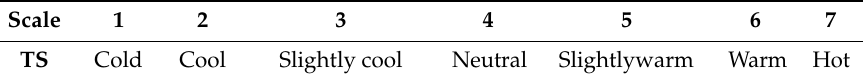
Table 1. Seven-point ASHRAE thermal sensation scale [30].